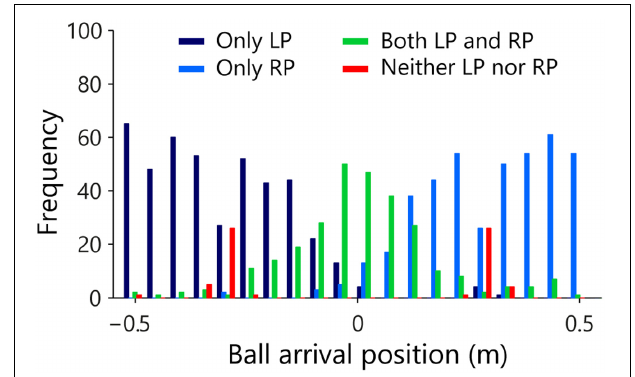
FIGURE 5 | Frequency distribution of the observed movement initiations of the LP and RP as a function of ball arrival position. Each trial arriving in one of 20 (5.25-cm wide) bins was classified as indicating initiation of only LP (dark blue), only RP (light blue), both LP and RP (green) or neither LP nor RP